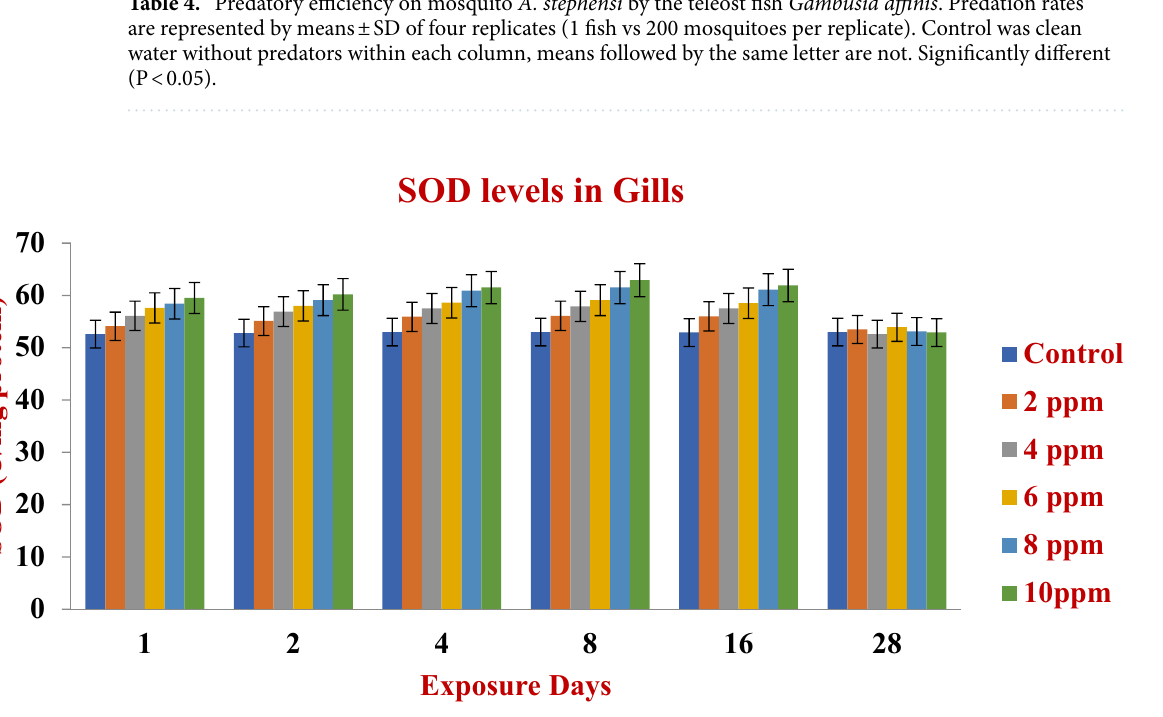
Figure 7. SOD enzymes in the gill region after the exposure (1–28 days) to AgNPs at different